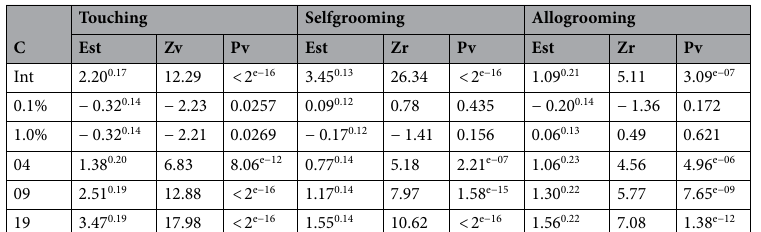
(Table 1). The frequency of self-grooming behavior, 01:01, 01:04, 01:09 and 01:19 groups, did not differ between the concentrations of quinone inside inhibitor fungicide and the control (Table 1). The frequency of self-grooming behavior increased, reaching a higher value in the 01:04, 01:09 and 01:19 groups than in the 01:01 (Table 1, Fig. 1), but it did not differ between the concentrations of 0.1%, 1% of quinone inside inhibitors fungicide and the control (Table 1).